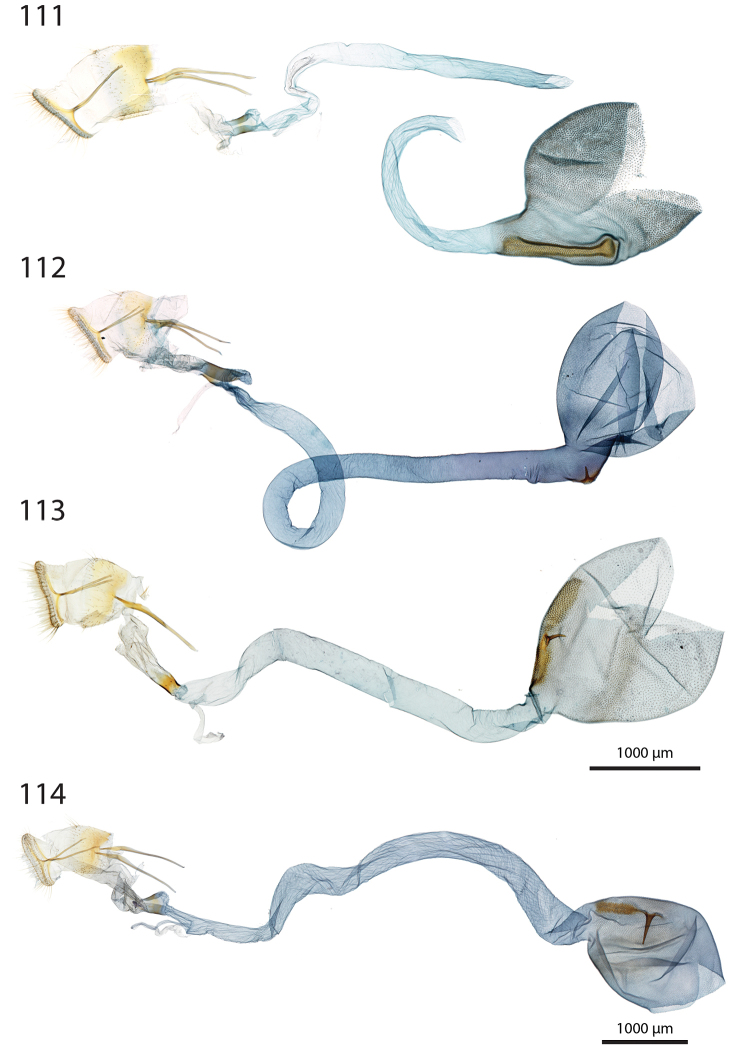
Female genitalia features of Hoploscopa. 111Hoploscopa
anacantha sp. nov., paratype, TL732 ♀ 112Hoploscopa
kelama sp. nov., paratype, TL665 ♀ 113Hoploscopa
ignitamaculae sp. nov., paratype, TL364 ♀ 114Hoploscopa
albomaculata sp. nov., paratype, TL529 ♀.